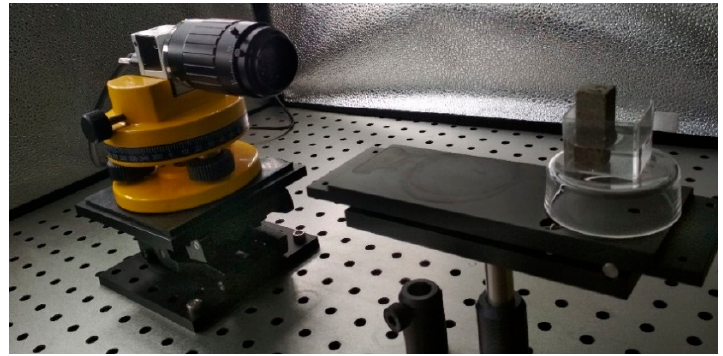
Figure 2. Setup for the imaging system and sample.